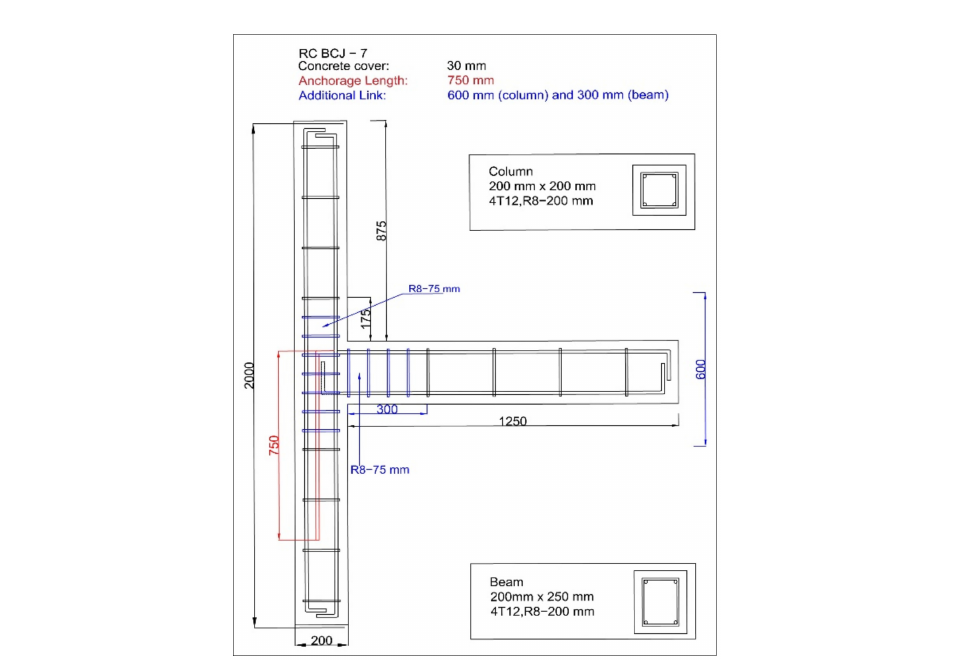
Figure 1. Detailing of every RC beam-column joint specimen.